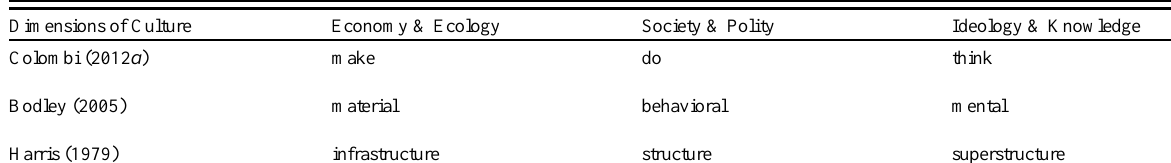
Table 1 . Comparisons of adaptive capacity elements with dimensions of culture from a selection of